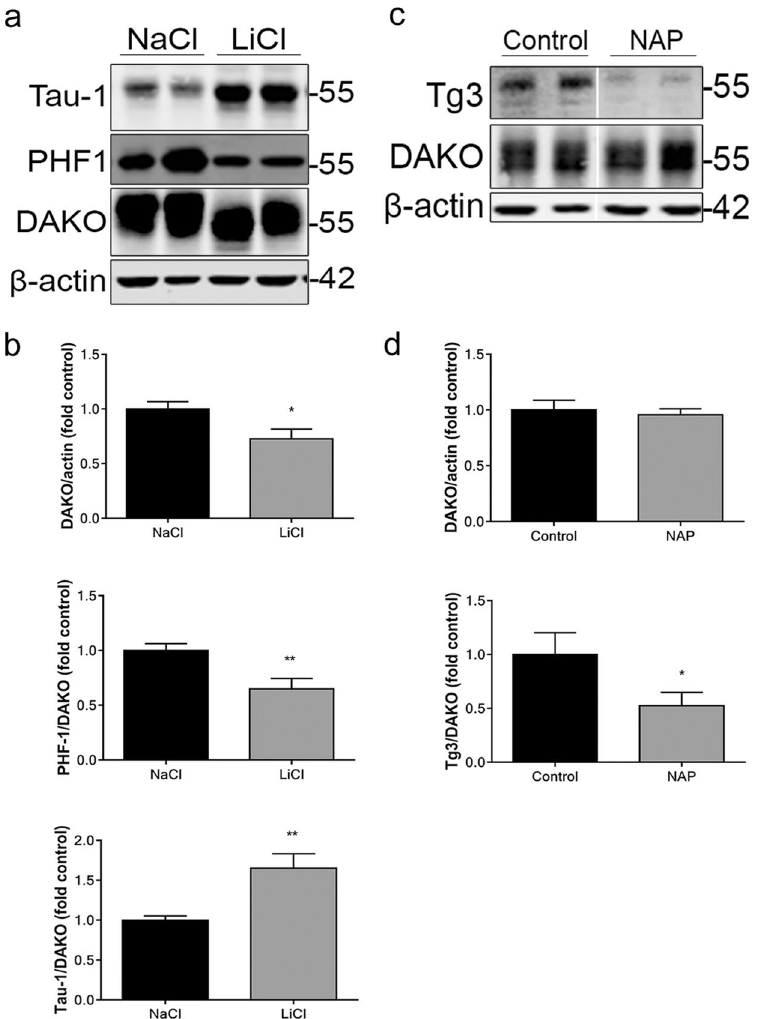
Figure 1. LiCl and NAPVSIPQ reduces tau phosphorylation in organotypic brain slice cultures from 3xTg-AD mice. Representative western blots of lysates from 28 DIV 3xTg-AD organotypic brain slice cultures treated with ( a ) 20 mM LiCl or 20 mM NaCl (control) for 4 h, or ( c ) 100 nM NAP or control (H 2 O) for 4 h. Blots were probed with antibodies against total tau (both non-phosphorylated and phosphorylated; DAKO), PHF-1 (phospho-Ser396/404), Tau-1 (dephospho-Ser202/Thr205) and Tg3 (phospho-Thr231). Blots were also probed with an antibody against β -actin as a loading control. Bar charts show amounts of total tau relative to β -actin in each sample, and phospho-tau as a proportion of total tau in each sample after treatment with ( b ) 20 mM LiCl or 20 mM NaCl (control) (all data analysed by unpaired t-test) or ( d ) 100 nM NAP or control (H 2 O). n = 9–12. (DAKO/actin analysed by Mann Whitney U test, Tg3/DAKO analysed by unpaired t-test). Data is mean ± SEM and is shown as fold change from control. * p < 0.05, ** p <